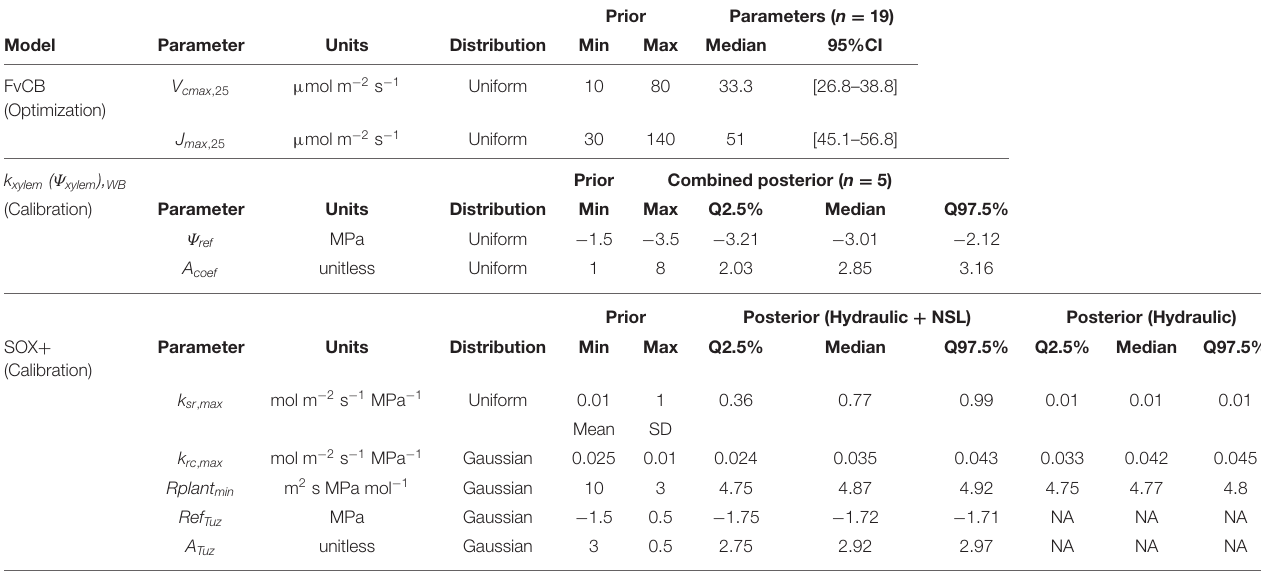
TABLE 2 | Results of the three-step SOX + model